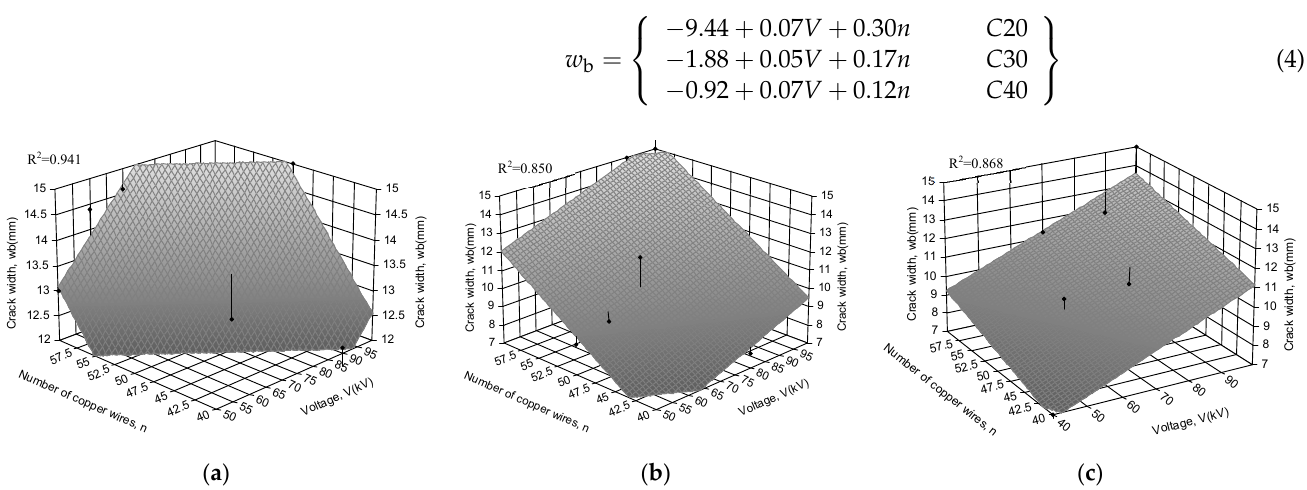
Figure 14. Fitting surface of concrete crack width with copper wire number and discharge voltage at 400 mm hole spacing.